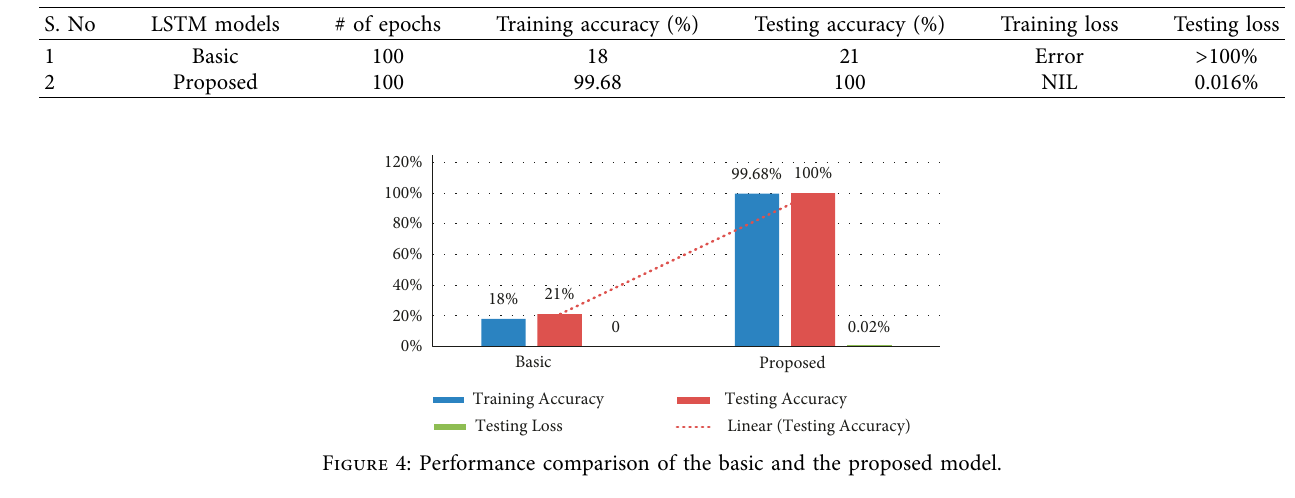
Table 3: Comparative analysis of classification accuracies.